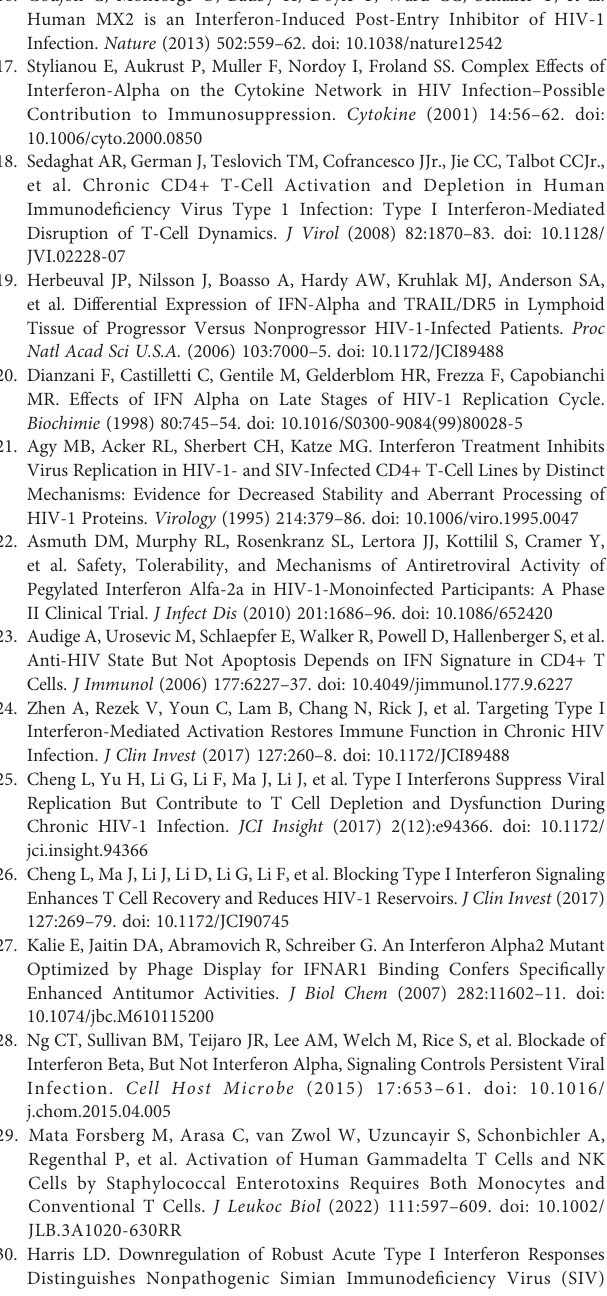
Supplementary Figure 1 | Cytokine and chemokine concentrations in supernatants from HIV- and mock-infected LPMCs after treatment with distinct type I IFN subtypes LPMCs were infected with X4-HIV-1 NL4-3-IRES- Ren and treated with 2000 U/ml IFN a 2, IFN a 14, IFN b , or remained untreated (-IFN). Supernatants were harvested 4 dpi and IFN a 2, CCL5, IL- 2, IFN g , IL-7, IL-1RA, TNF a , CXCL10, CCL3, and IL-10 (top) as well as IL-6, CCL2,G-CSF, and CXCL8 (bottom) were analyzed simultaneously by a multiplex bead-based assay. Concentrations of the different detected Cytokines and chemokines are depicted in a heatmap. Mean values ± SEM are shown for